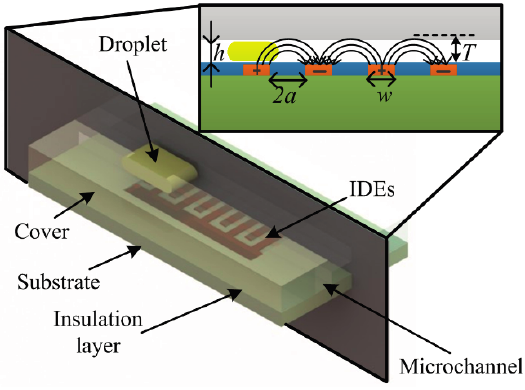
Figure 1. Structure of the sensing elements and cross-section of the sensor, showing how distinct materials cross the sensing area and the electrical field